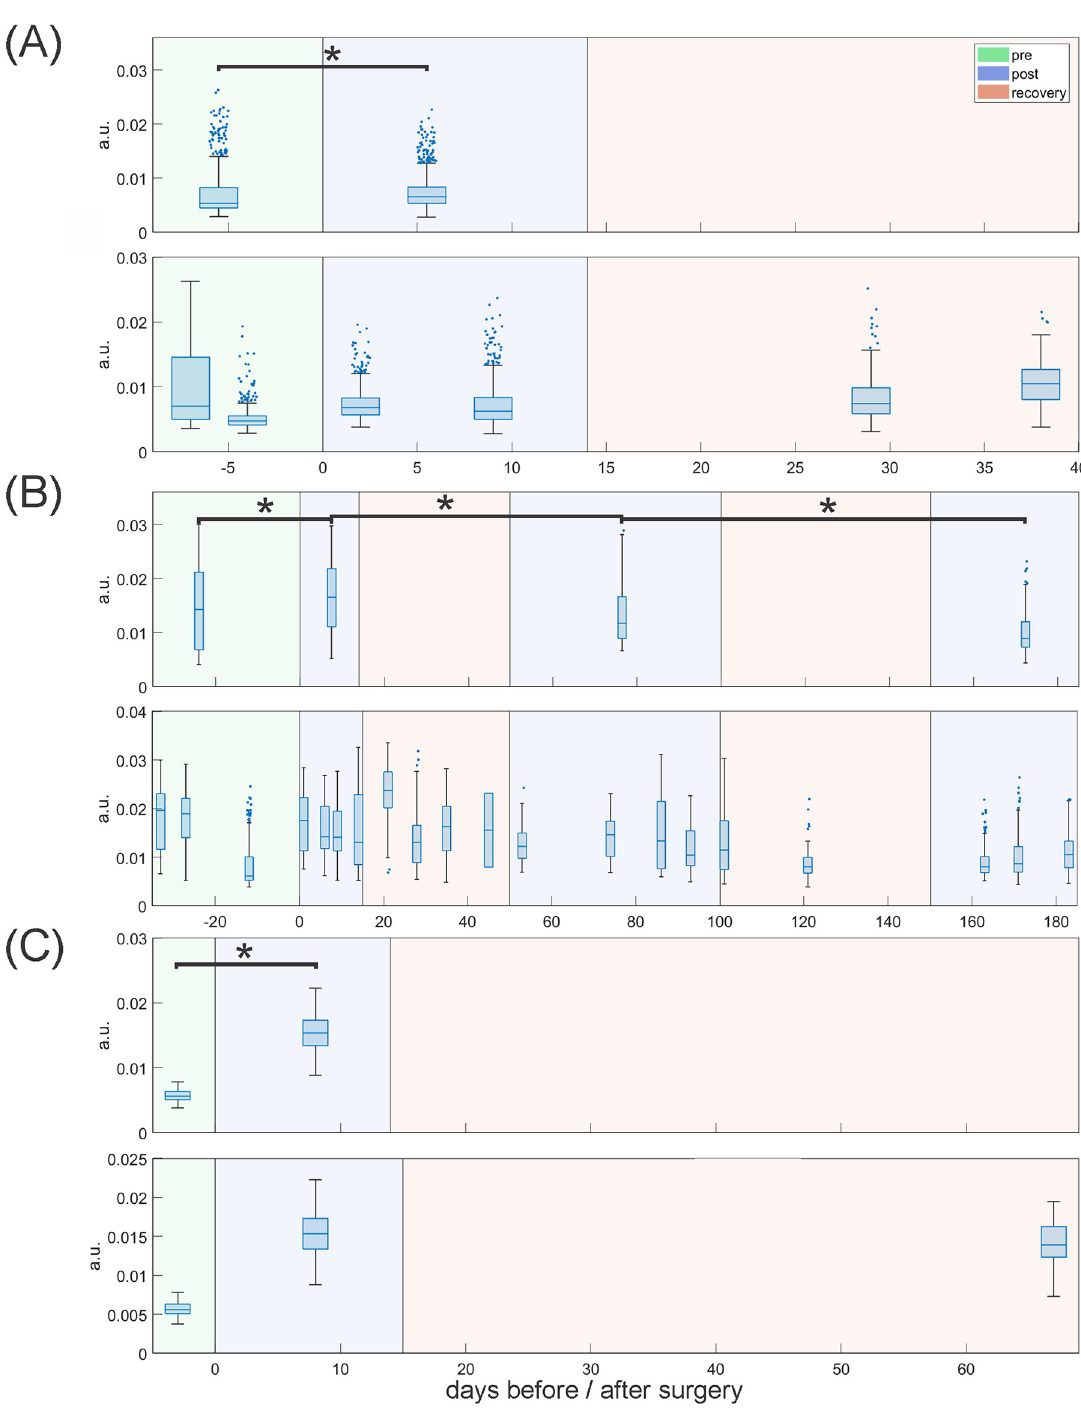
Fig 11. Change of Flux1 over time before and after COVR implant in (A) pig 3, (B) pig 4 and (C) pig 8. For statistical comparison in each section the top row shows boxplots of the random samples taken for analysis from the different time ranges (before surgery, up to 14 days after surgery, 50–100 days after surgery and more than 150 days after surgery). Bottom rows shows all recorded squeals on the dates indicated in the X-axis. The X-axis separates days before and after surgery at day 0. Data in the < 0 days and 0–14 days area was compared for pre-post-surgery comparisons. Pig 4 (B) also includes long-term comparisons. Asterisks indicate p < 0.05.